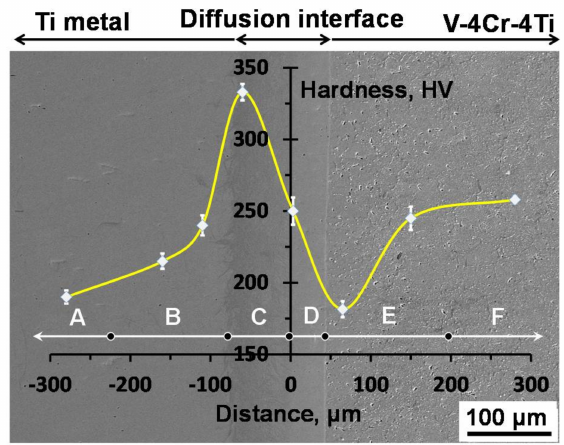
Figure 4. Vickers-hardness distribution across the V–4Cr–4Ti/Ti joint.